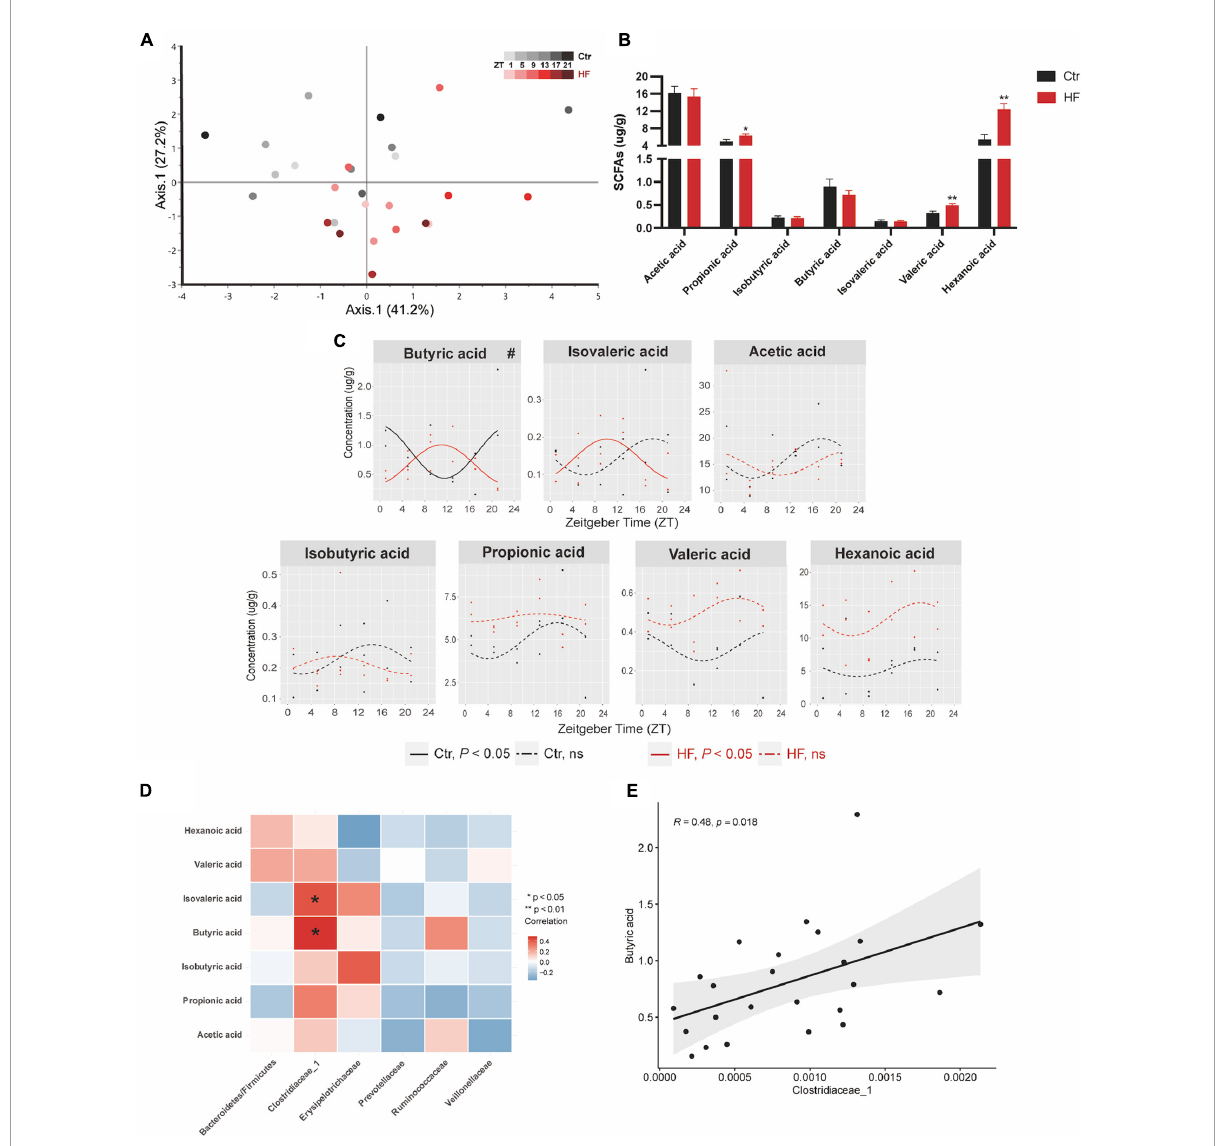
FIGURE5 High-fat diet modulated the diurnal rhythm of gut microbiota-derived short-chain fatty acids. Mice were fed with a standard chow diet, or a high-fat diet prior to pregnancy for 5 weeks, and throughout pregnancy. The morning of vaginal plug confirmed the pregnancy and was considered E0.5. On E18.5, pregnant mice were killed at 4-h intervals over 24 h. (A) Euclidean distance PCoA. Shading represents different time points as indicated. (B) Relative abundance and (C) diurnal patterns of SCFAs. (D) Heatmap of correlation analysis between SCFAs and the altered family. (E) Correlation analysis between butyric acid and Clostridiaceae_1 . Significant rhythms ( P < 0.05) are denoted by the continuous line, and non-significant rhythms are denoted by the dotted line. The dots mark individual measurements in each zeitgeber time (ZT), and line represents cosinor regression fit. Rhythmic pattern of genes with significant differences in phase (#) derived from CircaCompare ( n = 2–3/time point). Data of bar chart are expressed as means ± S.E.M. ( n = 12/group) using Student’s t -test; * p < 0.05 and ** p < 0.01. Ctr, standard chow diet-fed pregnant mice; HF, high-fat diet-fed pregnant mice; SCFAs, short-chain fatty